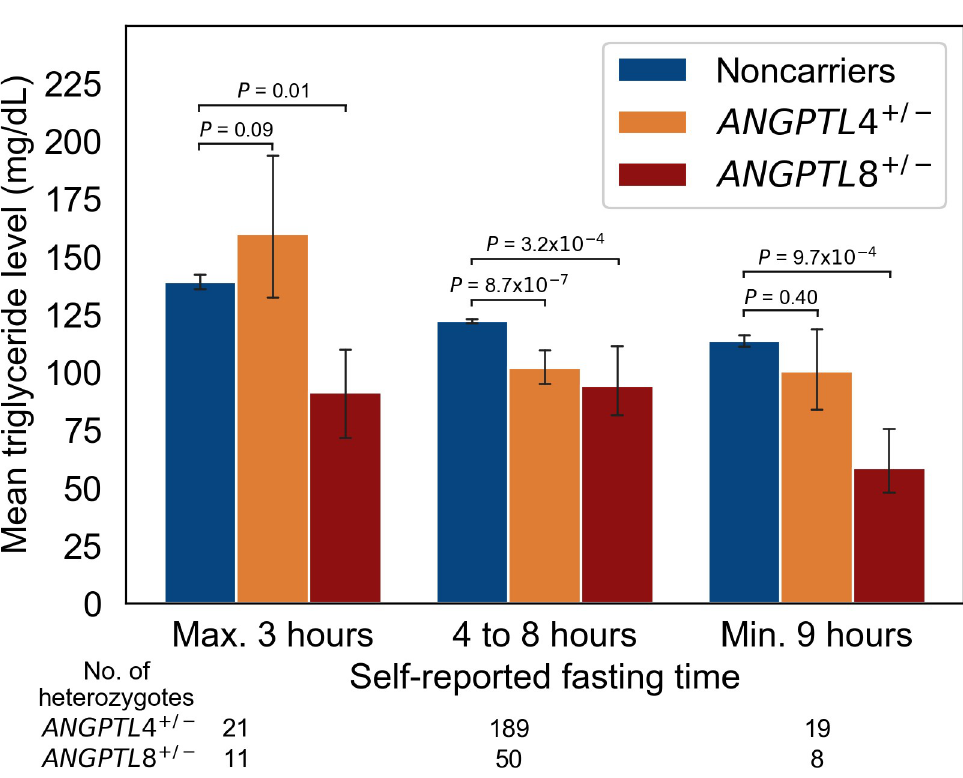
Fig 2. Mean serum triglyceride levels of ANGPTL4 and ANGPTL8 PTV heterozygotes at their self-reported fasting time in the Finrisk Study. a a The figure shows the mean serum triglyceride level by ANGPTL4 and ANGPTL8 PTV carrier status with respect to self-reported fasting time. The number of ANGPTL4 and ANGPTL8 heterozygotes for each fasting time interval are reported below the fasting time legend. The height of the bars indicate means and the error bars 95% confidence intervals. The P values are for the two-sided Welch’s t-test of the natural logarithm of triglyceride levels between noncarriers and heterozygotes.